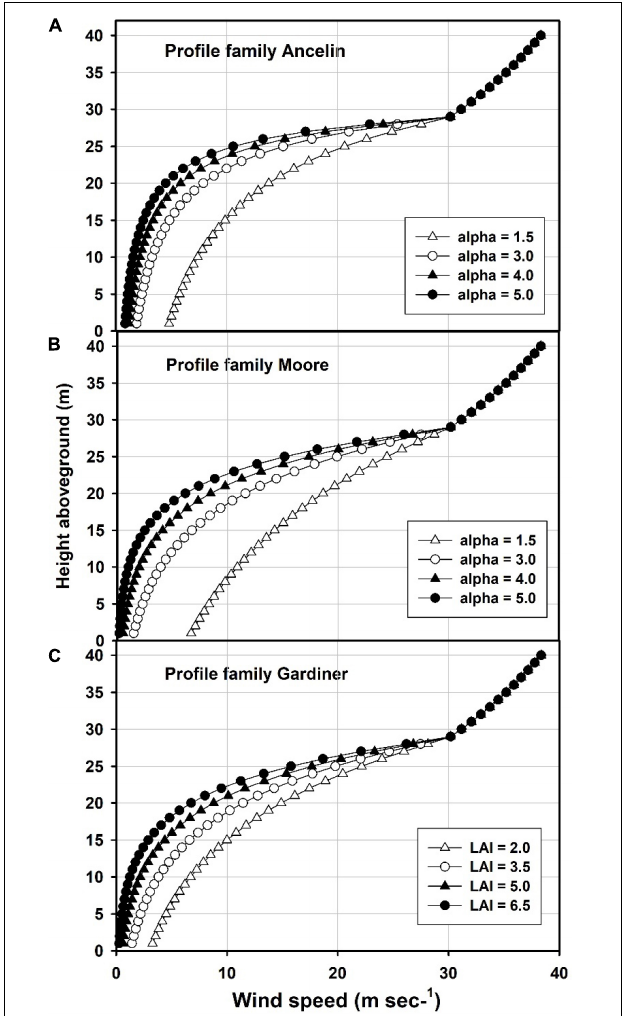
FIGURE 1 | Vertical wind profiles produced by four attenuation factors and three different profile formulas, when above-canopy wind speed was 30 m s − 1 . (A) Profile family Ancelin; (B) profile family Moore; (C) profile family Gardiner. Profile family Ancelin and profile family Moore calculate the profile on the basis of an attenuation coefficient alpha, while profile family Gardiner calculates the profile on the basis of leaf area index (LAI). Mean canopy height was 27.8 m; wind speeds above this height were identical for the three profile